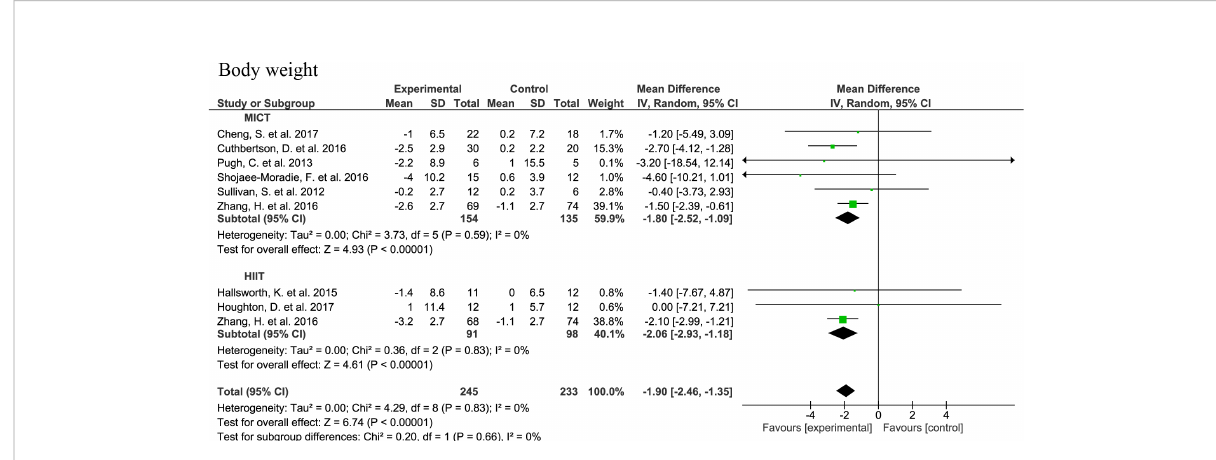
FIGURE 4 Forrest plot for the effect of moderate-interval continuous training (MICT) and high-intensity interval training (HIIT) on total body